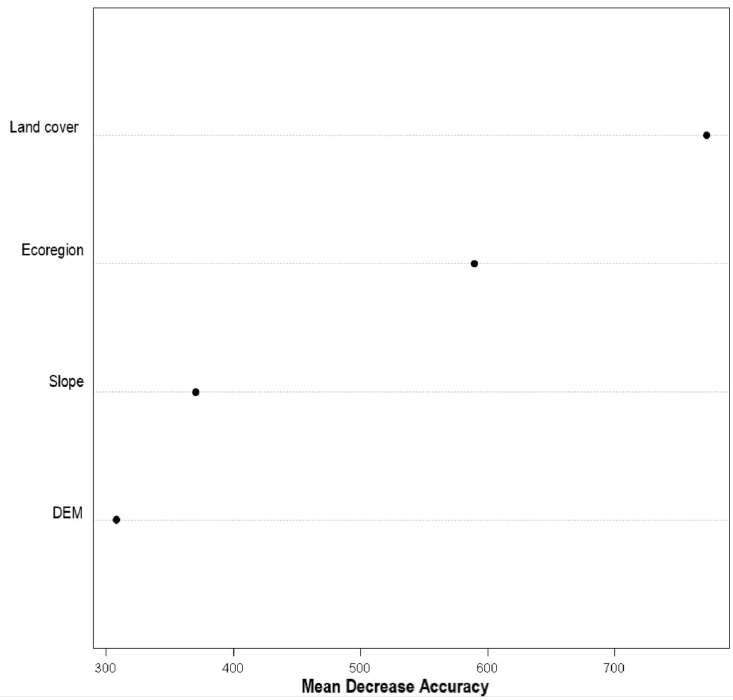
Figure 9. RF variable importance analysis for Santa Cruz based on the Mean Decrease